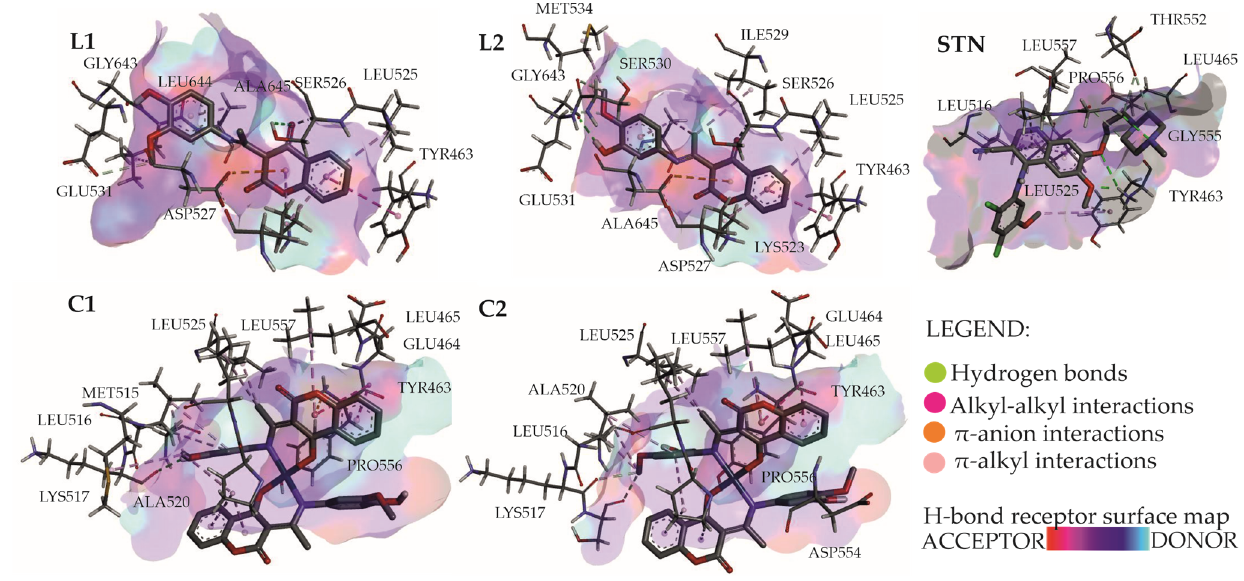
Figure 10. Molecular docking simulations: Interactions of L1, L2, C1, C2, and Bosutinib inside the active site of RTK, with H-bond receptor surface map.